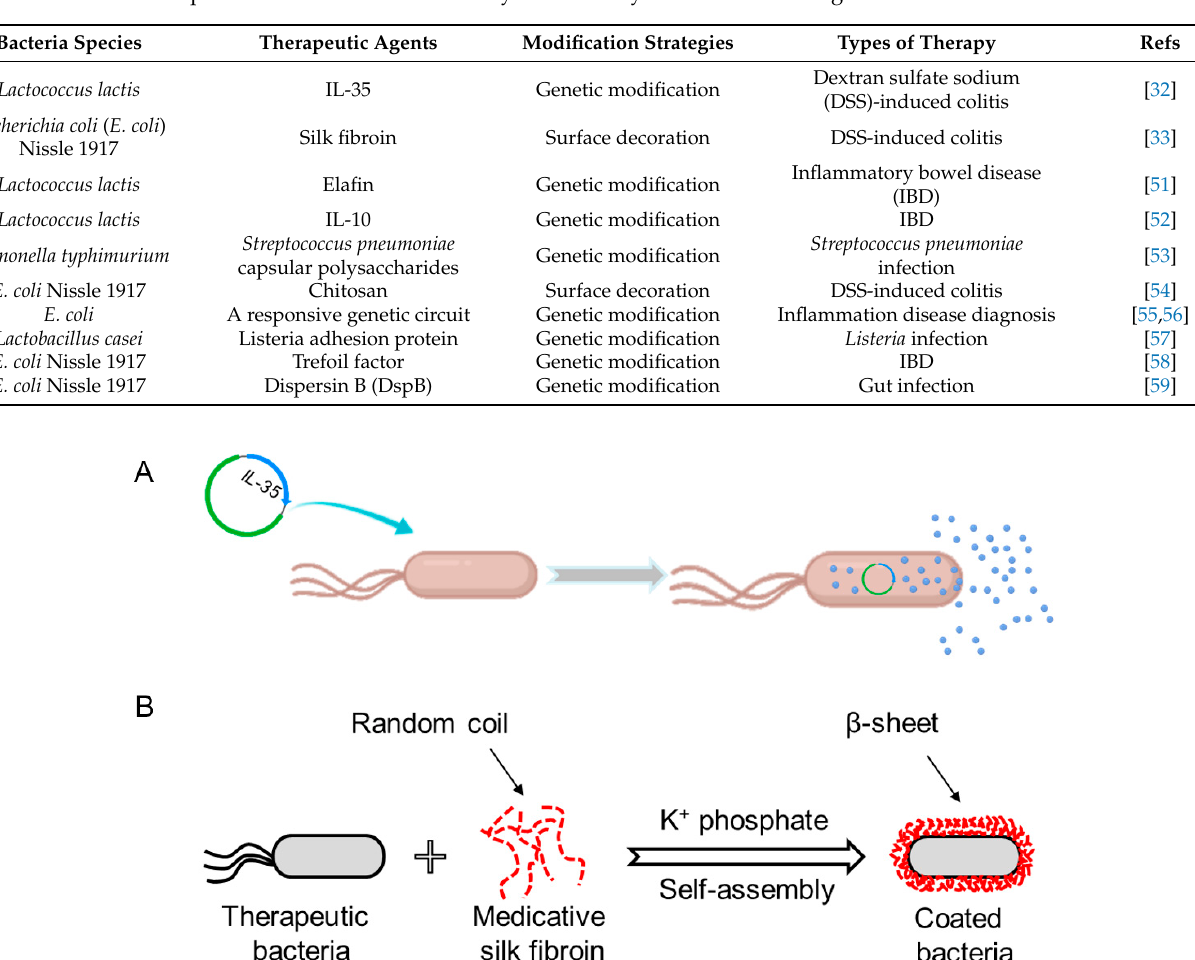
Table 1. Therapeutic biomacromolecules orally delivered by bacteria for treating intestinal infectious diseases.